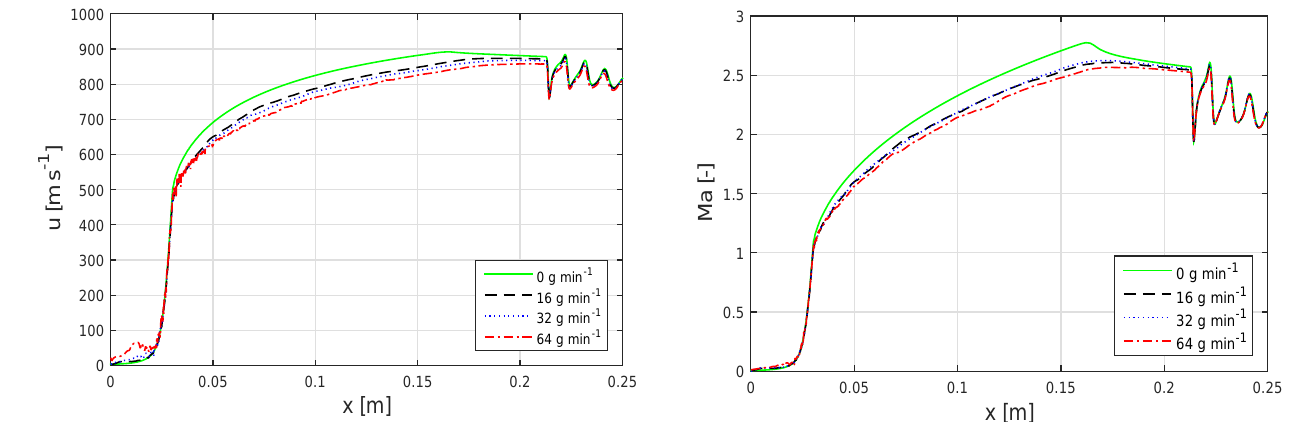
Figure 9. Comparison of gas Mach number along axial position